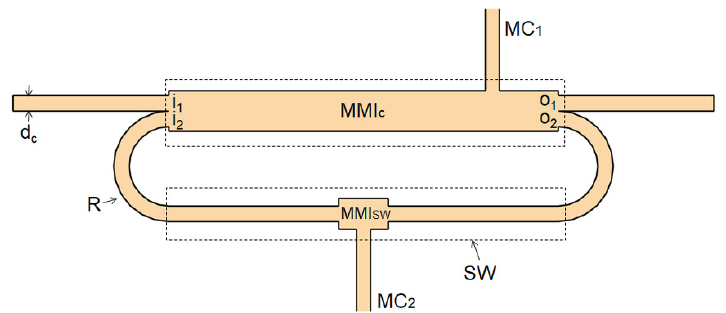
Figure 4. Schematic layout of the proposed optofluidic ring.